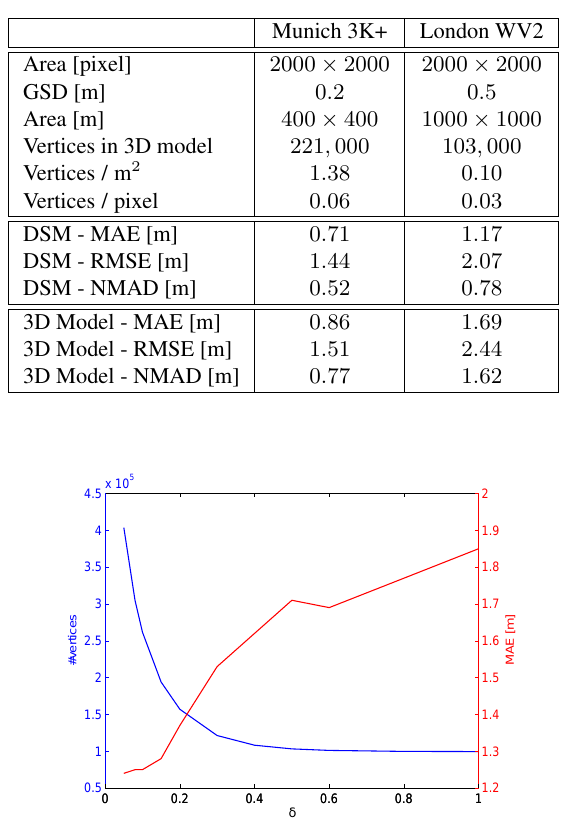
Figure 10: Influence of the mesh simplification parameter δ on the accuracy of the resulting 3D model (London data set). The correlation between the reduced number of vertices and increas- ing mean absolute error is clearly